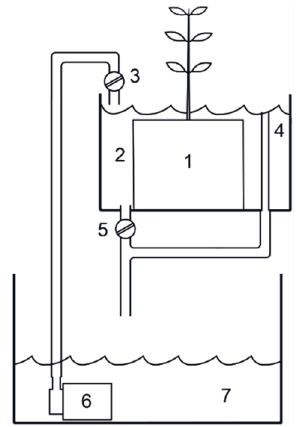
Figure 2. Schematic drawing of one section of the experimental microcosm setting with ( 1 ) an experimental seedling in its container, placed into ( 2 ) a tank. Altogether there were 18 tanks. Tanks had ( 3 ) an adjustable water inlet, ( 4 ) a spillway tube and ( 5 ) an adjustable water outflow. The adjustable water outflow regulated the artificial tiding between spring tide (as shown in drawing: 25 cm, 3 days), intermediate level 2 (18.5 cm, 2 days), intermediate level 1 (12 cm, 2 days) and neap tide (5.5 cm, 3 days). Water was pumped to the tanks with ( 6 ) electrical centrifugal aquarium pumps from ( 7 ) a water reservoir filled with natural seawater (salinity: 32